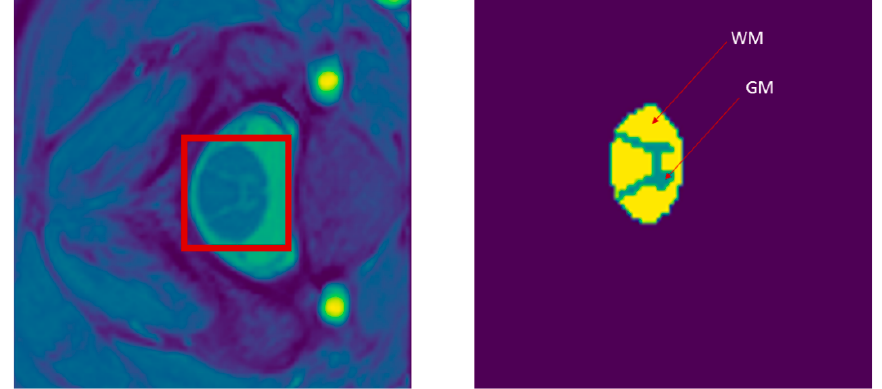
Figure 2. ( left ) Image slice of the spinal cord’s white matter (WM) and gray matter (GM). ( right ) WM and GM true-mask segmentation. The red rectangle shows the area of interest in the spinal cord displaying both gray matter and white matter.